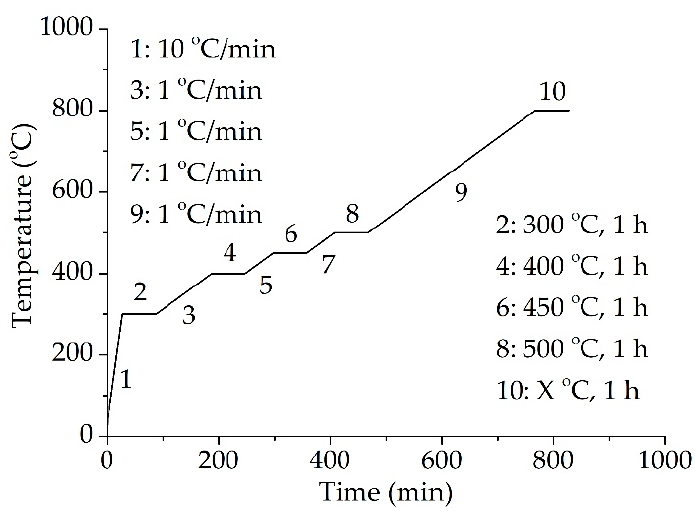
Figure 1. Temperature program for the sintering of the ceramic samples.